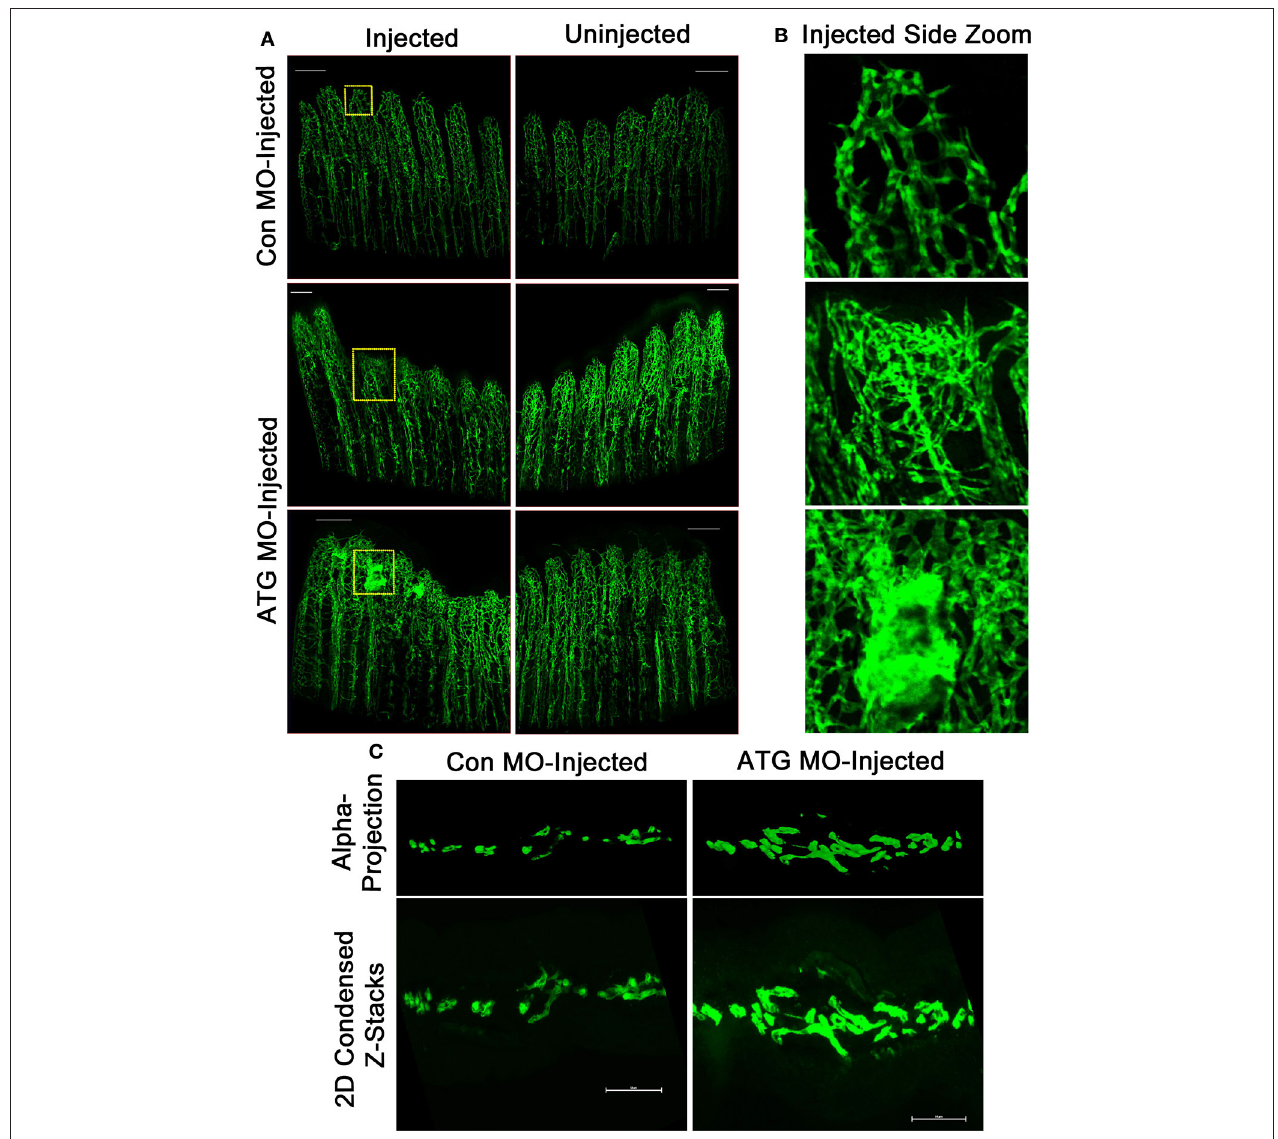
FIGURE 3 | Tmem184a MOs-mediated knockdown results in aberrant vascular regeneration. Representative fluorescence microscopy images of fixed 4 dpa Tg(Fli1:EGFP) whole and cryosectioned fins. Each MO was injected into regenerating tissue of fin rays 1–6 at 3 dpa, and the other side was left uninjected. (A) There is no obvious difference in vascular phenotype between the side of a fin injected with Con MO vs. the uninjected side. Con MO n = 12. Injection with ATG MO results in two predominant phenotypes: impaired vascular outgrowth (top) and tangled regenerating vasculature (bottom). ATG MO n = 18. Scale bars = 200 µ m. (B) 10x zoomed sections of injected fin shown in (A) allow easier discernment of regenerating vessels. (C) Example transverse maximum intensity projections (bottom) and alpha blended 3D projections (top) show the extent of vessel disorganization in an ATG MO-injected fin ray compared to one injected with Con MO. Scale bars = 50 µ